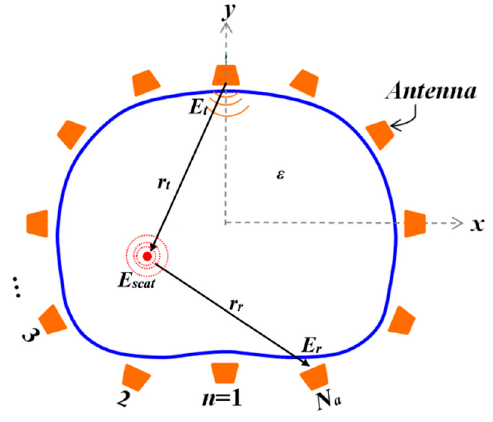
Figure 5. Imaging domain.